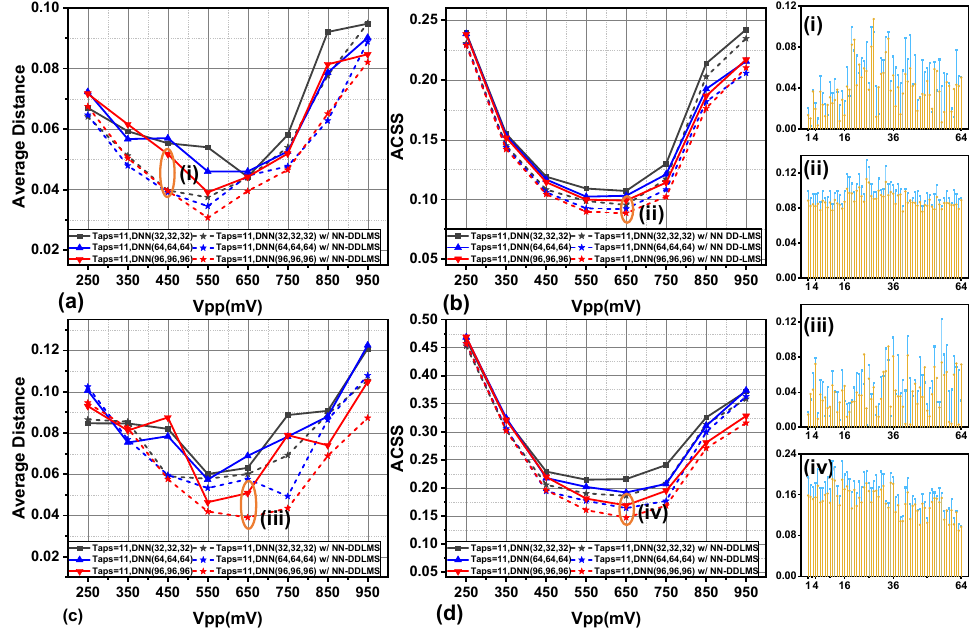
Figure 10. ( a ) The average distance between the center of received constellation points’ class and standard constellation points for 64APSK systems; ( b ) ACSS for 64APSK systems; ( c ) the average distance for 64QAM systems; ( d ) ACSS for 64QAM systems.